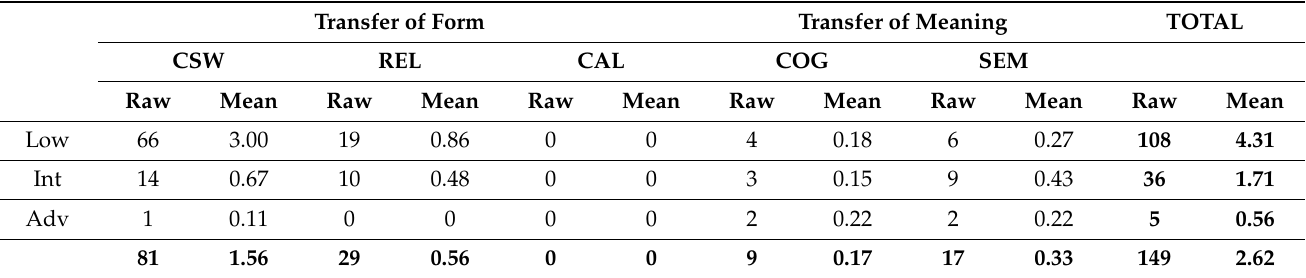
Table 5. Lexical CLI instances in written production.